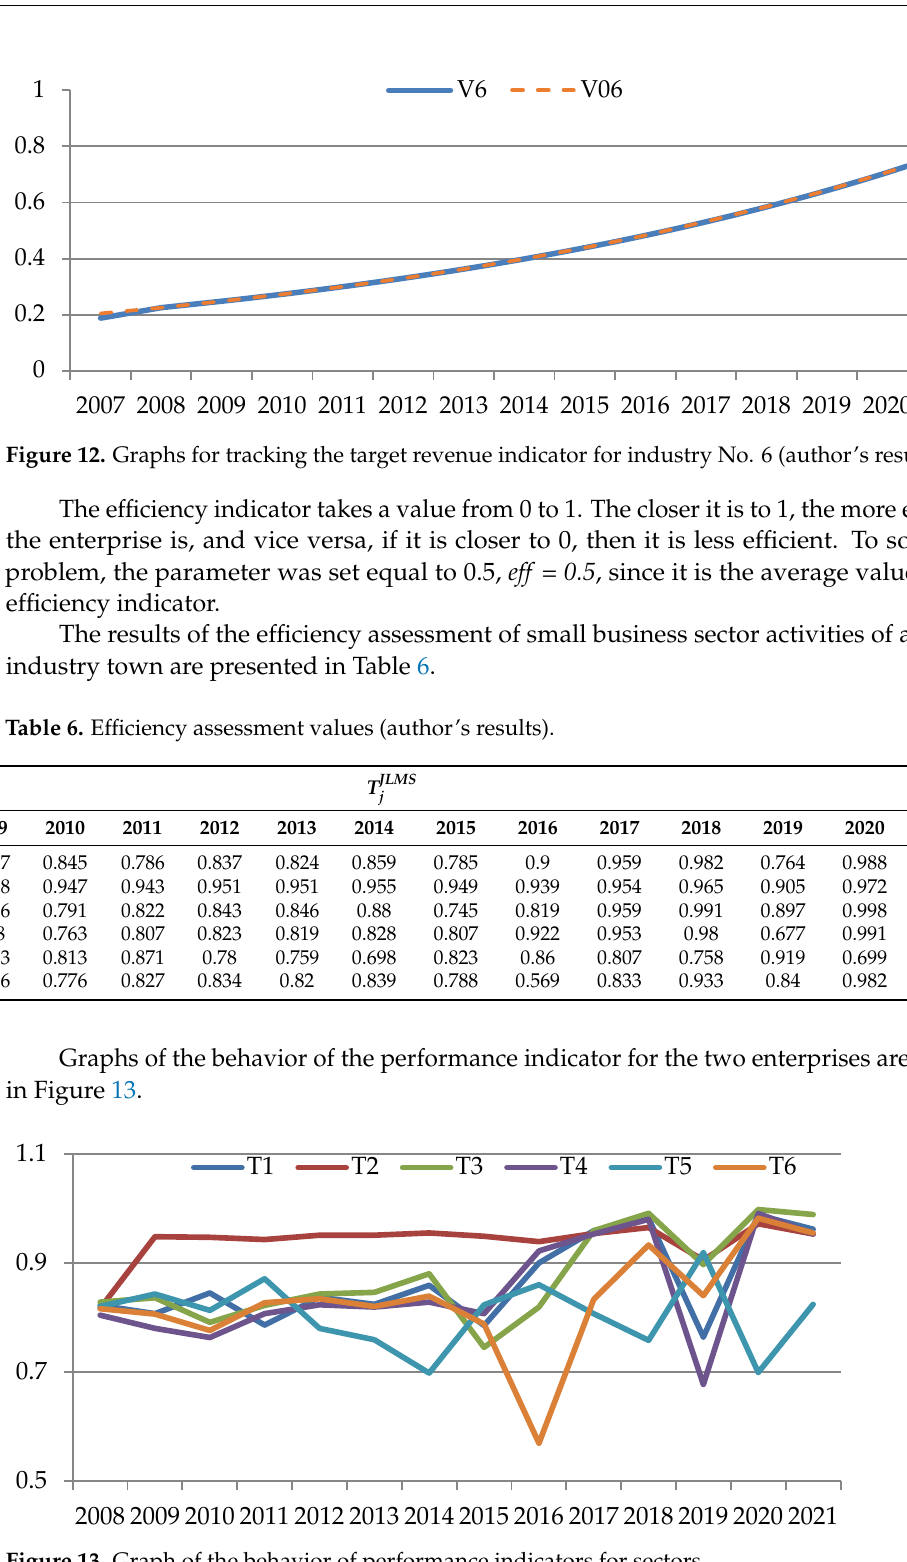
Figure 13. Graph of the behavior of performance indicators for sectors.